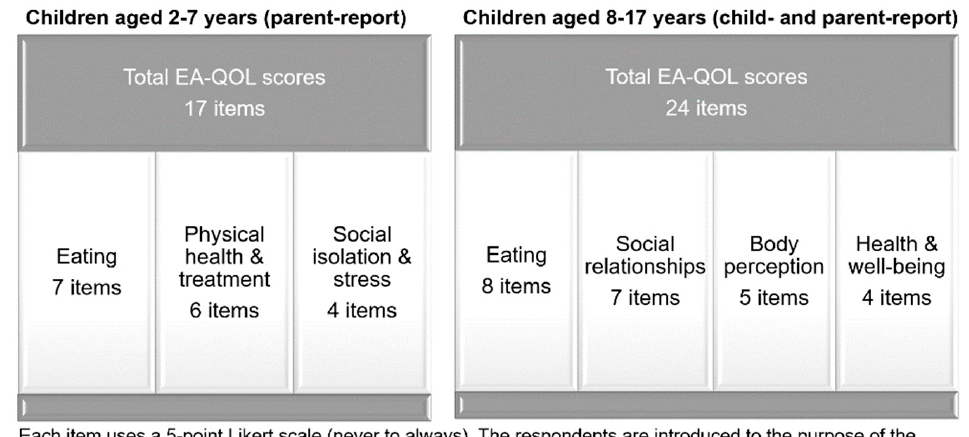
Figure 1. Format of the EA-QOL questionnaires for children aged 2–7 and 8–17.